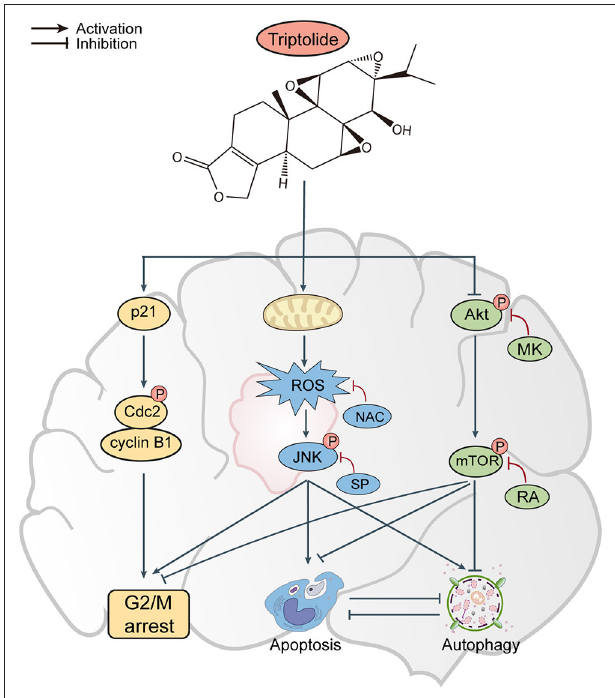
FIGURE 8 | Proposed mechanism of triptolide-induced apoptosis and autophagy in glioma